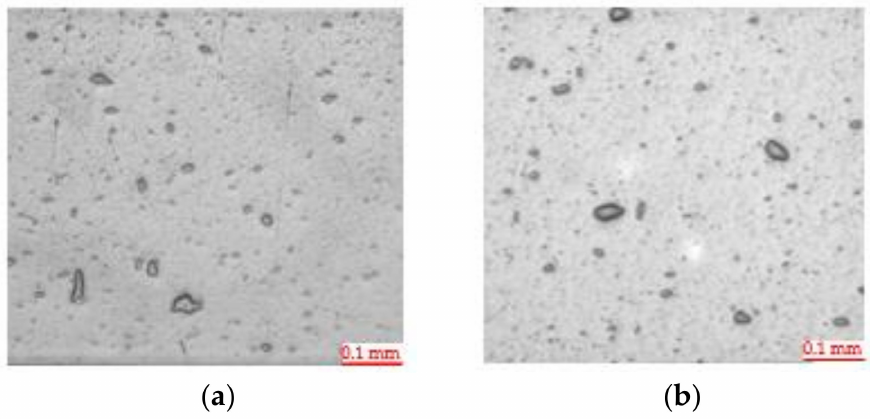
Figure 8. Optical microscopy of sheet samples ( a ) PET/PA_MXD6/nS_AMEO 1.1% nS, and ( b ) PET/PA_MXD6/nS_AMEO 2.1% nS. Table 5. Permeability to O 2 results of nanocomposite